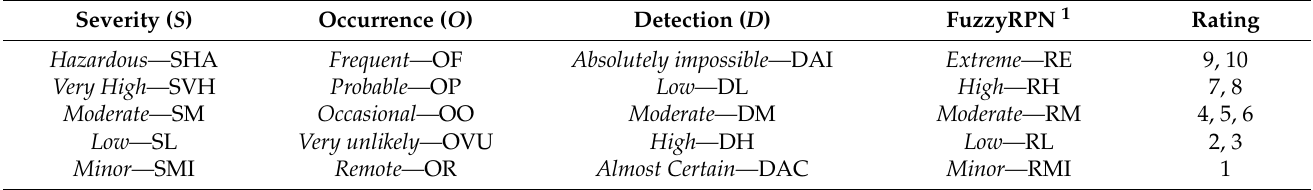
Table 5. Ratings for risk categories used as in the classical FMECA.